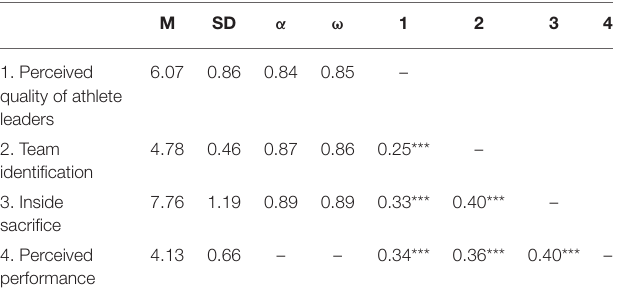
TABLE 2 | Means, standard deviations, bivariate correlations, and reliability analysis of the variables.